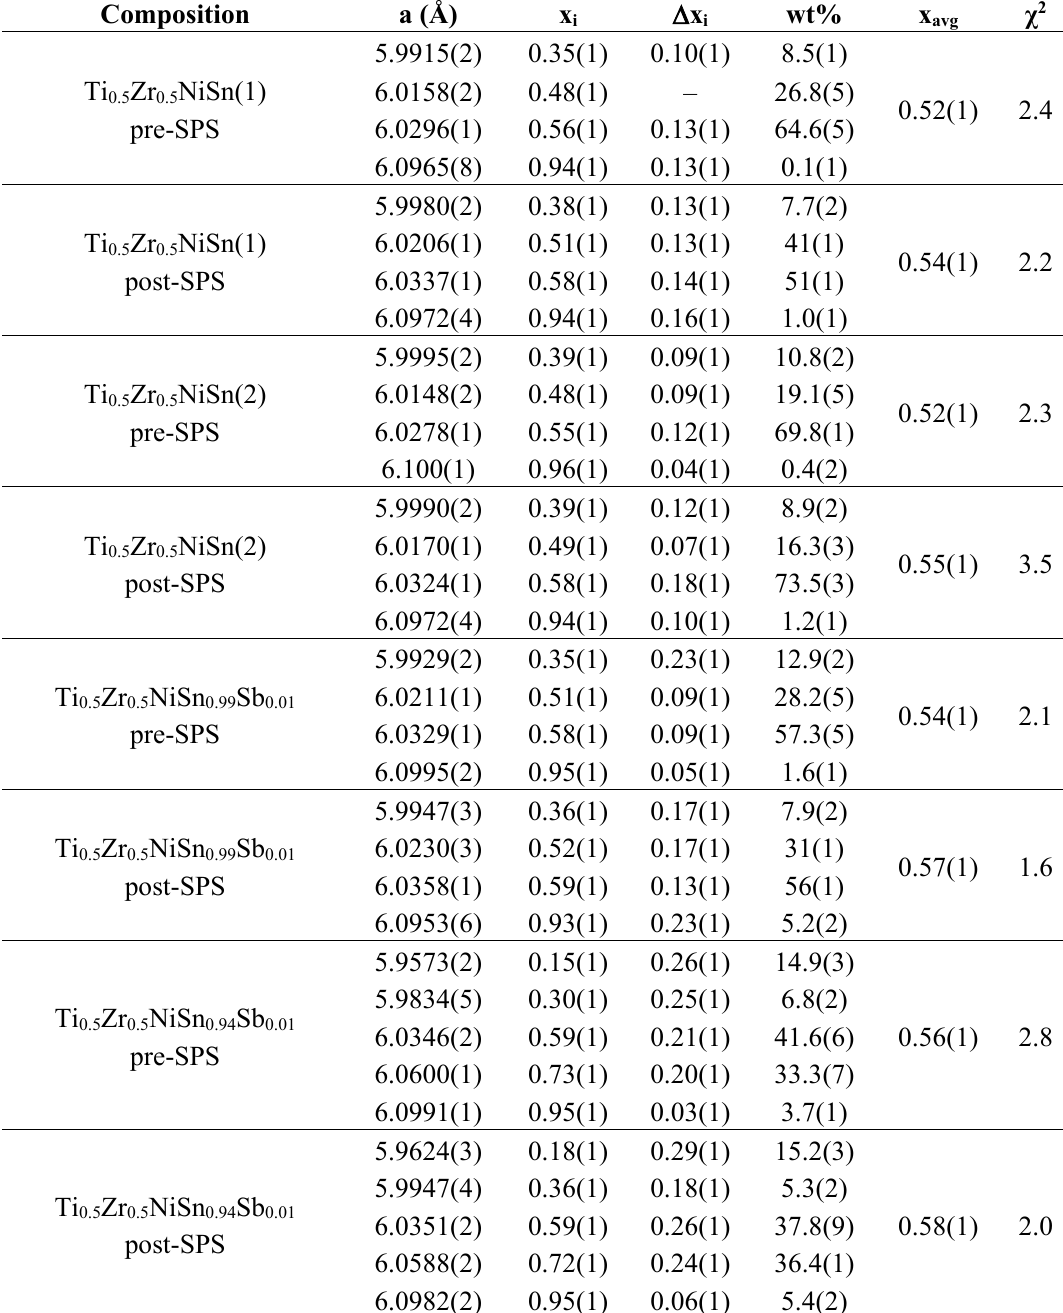
Table 2. Nominal composition, lattice parameter (a), Vegard composition (x i